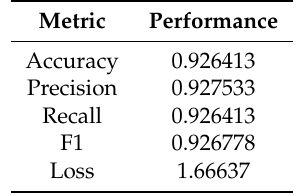
Table 8. Classification result of Decision Tree model on energy